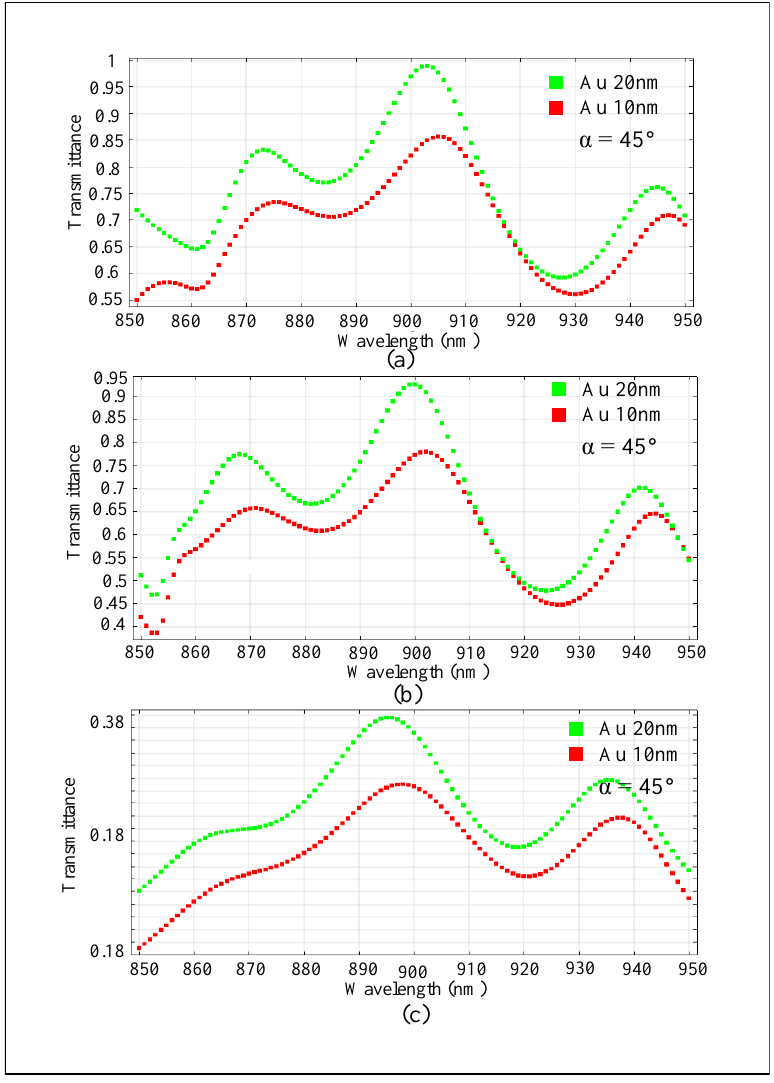
Figure 8. ( a ) The transmittance diagram for the PhC structure consisting of large GaAs nanorods and small Au nanorods with a deflection angle of 45°. ( b ) The transmittance diagram for the PhC structure consisting of large GaAs nanorods and small Ag nanorods with a deflection angle of 45°. ( c ) The transmittance diagram for the PhC structure consisting of large GaAs nanorods and small Al nanorods with a deflection angle of